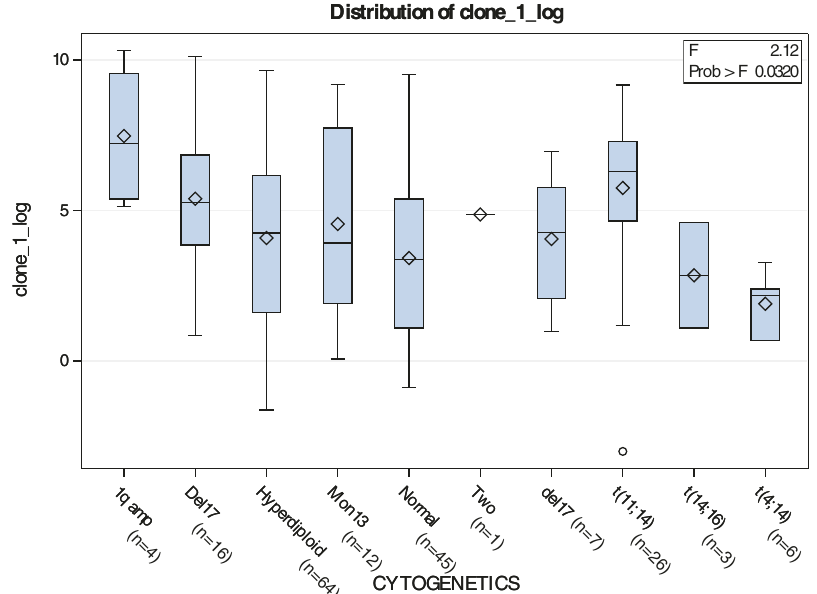
Fig. 2 Distribution of MRD clone by cytogenetic event. Log transformed MRD clone MRD and patients categorized based on primary cytogenetic events. General linear model (GLM) shows statistically higher levels in patients with 1amp (4 or more